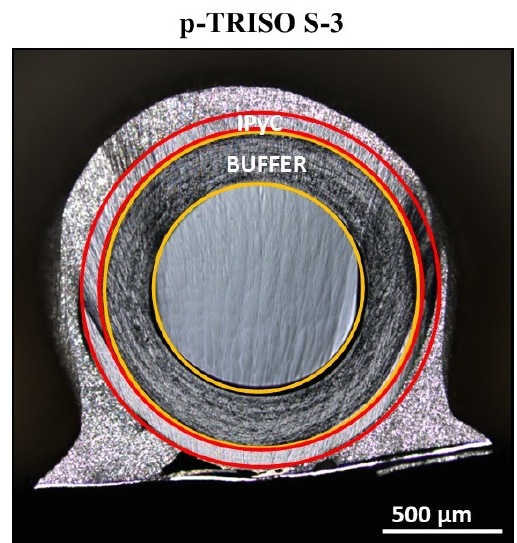
Figure 2. The SEM image of the cross-section of the S-3 p-TRISO sample; with the red color the IPyC layer (thickness: ~65 µ m, density: 1.84 g/cm 3 ) and with yellow color of the Buffer layer (thickness: ~100 µ m, density: 0.97 g/cm 3 ) were